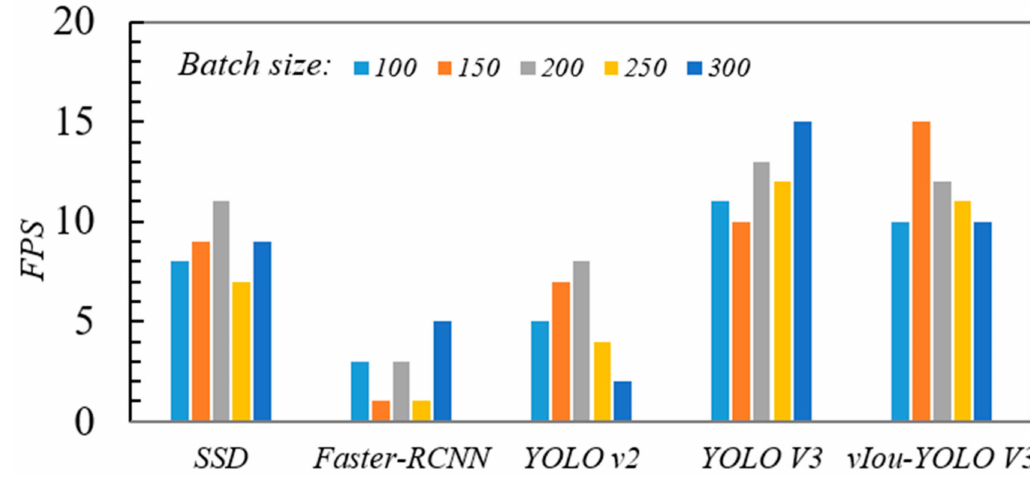
Figure 16. The fps versus batch size in five detection